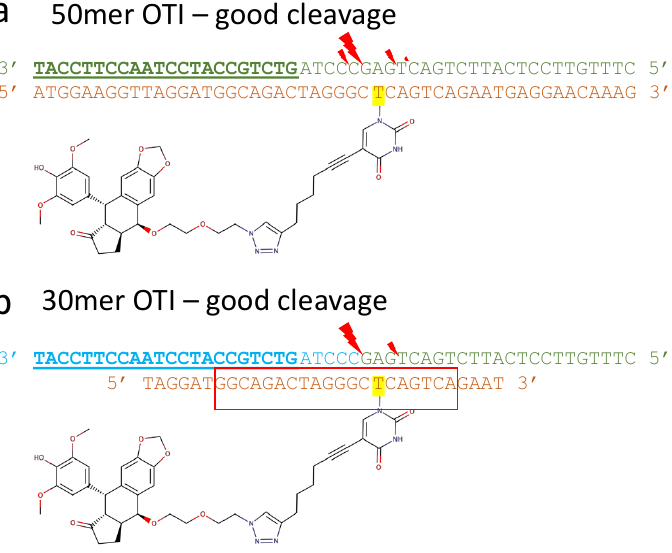
Figure 4. 50 mer and 30 mer Watson–Crick-OTIs cleave an oncogene target sequence. Adapted from Figure 9 in [43] focusing on Top2 α cleavage. ( a ) The target oncogenic PML-RARA sequence to be cleaved is shown in green on the top line, with the RARA sequence bold and underlined at the 3 (cid:48) end; the 5 (cid:48) sequence is from PML . The bottom line shows the 50 mer OTI with an etoposide moiety covalently attached to the T (highlighted in yellow). DNA-cleavage gels showed that the OTI promoted DNA-cleavage at four sites on the target (green) strand with relative intensities (in brackets) 24–25 (17), 23–24 (45), 20–21 (17), 19–20 (5). ( b ) The same target PML-RARA sequence is shown on the top line, but coloured in cyan at the 3 (cid:48) end to indicate the position of the major cleavage site. Only two DNA-cleavage sites were observed with the 30 mer OTI, 23–24 (32), 20–21 (9) (red lightning bolts show positions). The red box indicates where the 20 nucleotides are from Xtal structures with etoposide (pdb codes: 3qx3, 5cdn and 5cdp);–based on the major DNA-cleavage site.